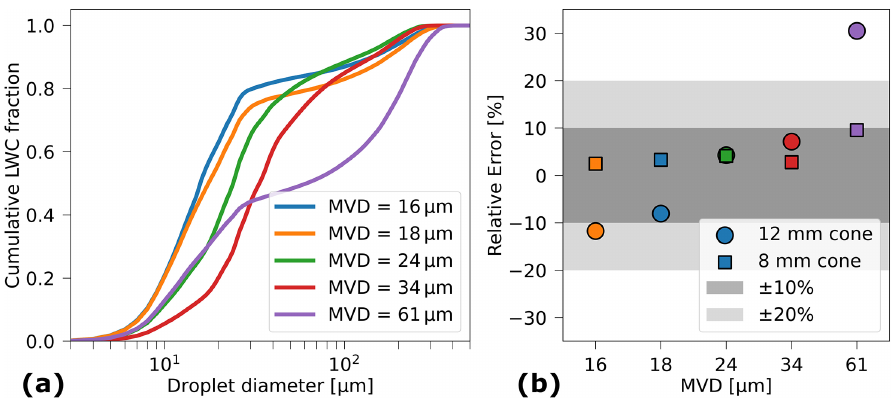
Figure 8. (a) Cumulative liquid water content of the bimodal DSDs measured in the BIWT. The distributions with the MVDs of 16, 18 and 61µm have a small droplet mode centered around 15µm and a large droplet mode at approximately 230µm. They differ mainly in the ratio of LWC contained in small droplets to LWC contained in large droplets. The distributions with MVDs of 24 and 34µm have their small droplet mode centered at 20 and 30µm respectively and their large droplet mode at 166µm. (b) Relative error of the LWC estimate that is introduced when approximating the collision efficiency from the MVD as compared to the collision efficiency estimated using the DSDs shown on the left side.